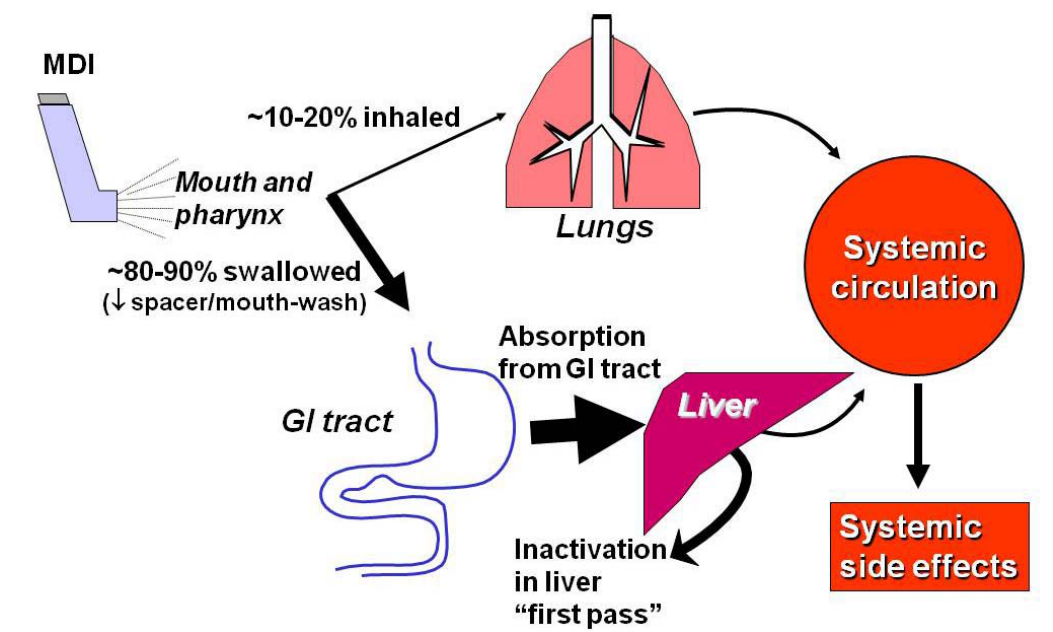
Figure 7. Pharmacokinetics of inhaled glucocorticoids. GI =